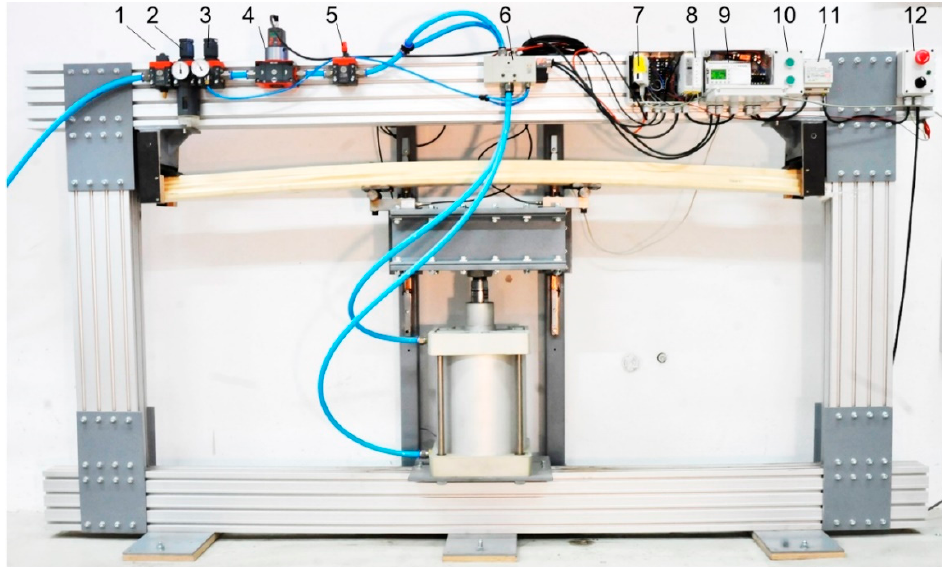
Figure 5. Fatigue test rig components: 1. Cut-off switch, 2. Air preparation unit, 3. Regulator for the